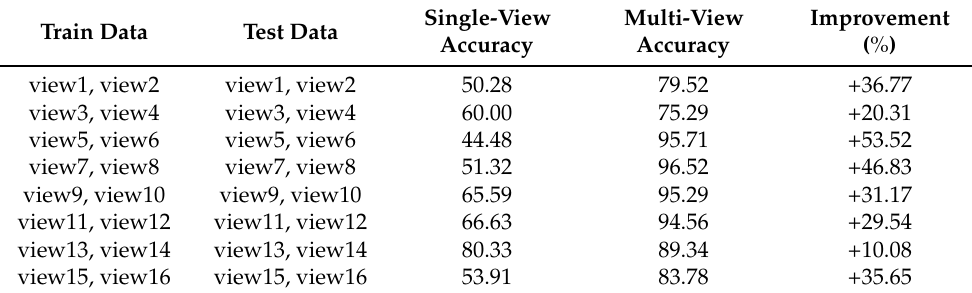
Table 5. Model accuracy of single-view and multi-view learning on our UJM-TIV dataset. Train